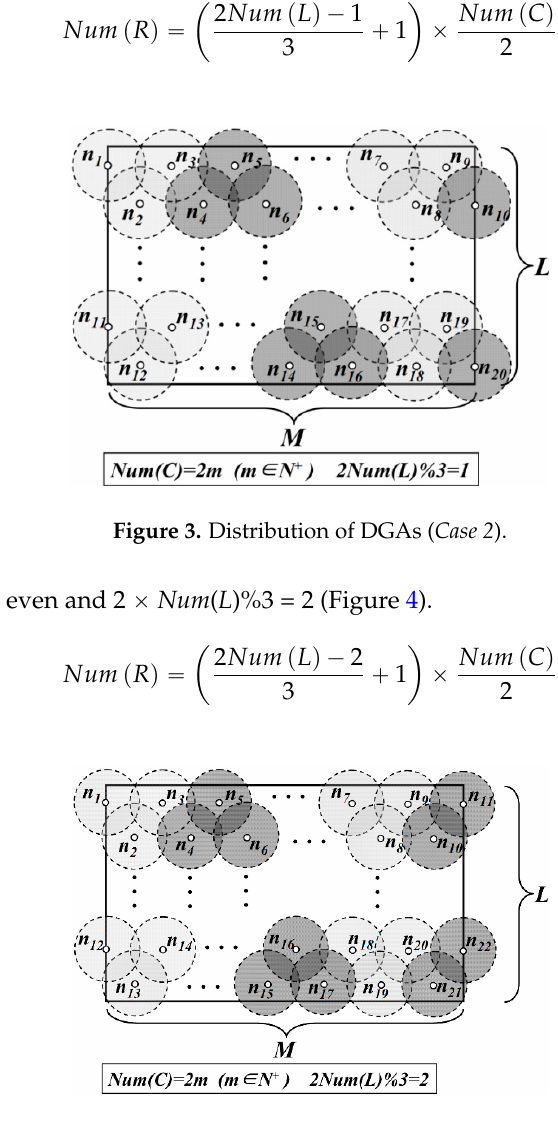
Figure 2. Distribution of DGAs ( Case 1 ).